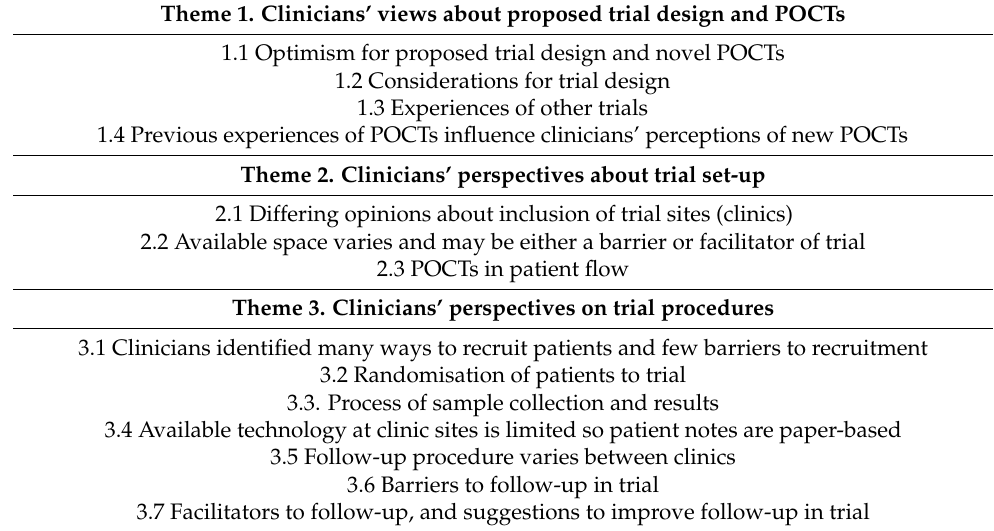
Table 1. Main themes and